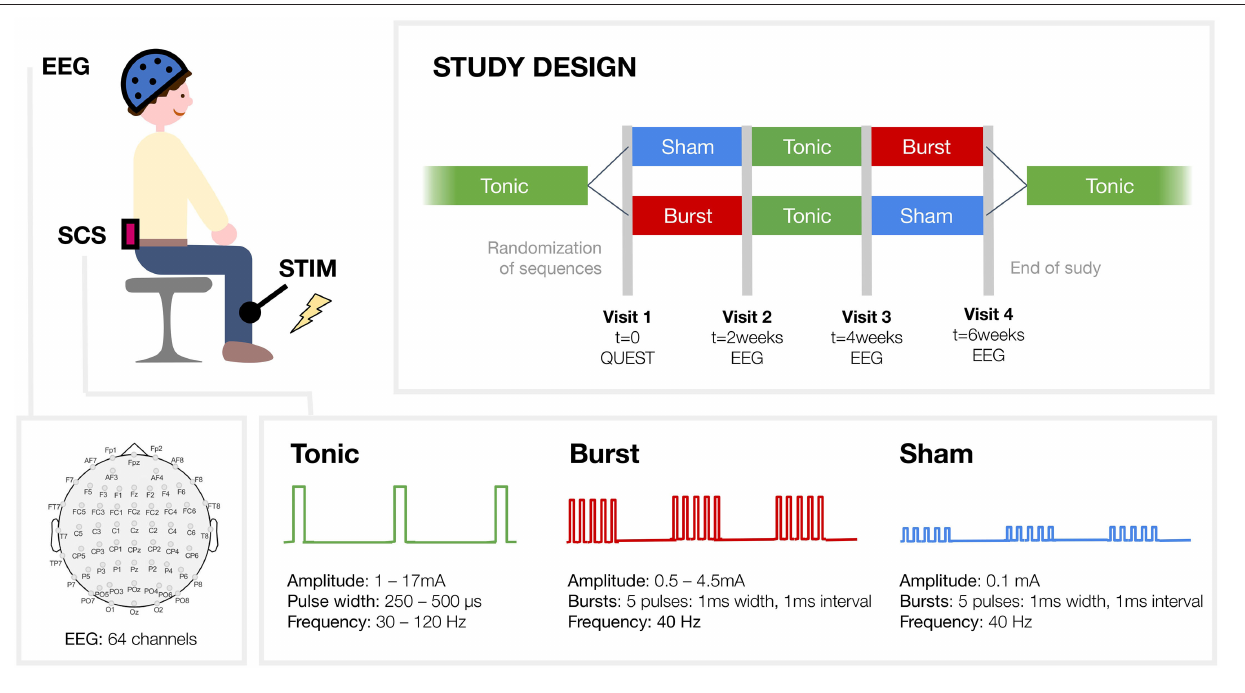
FIGURE 1 | Study design. Patients were evaluating three different spinal cord stimulation (SCS) regimes, each for 2 week: conventional tonic SCS, burst SCS and sham SCS. Participants were randomized to one of the two study arms. Tibial nerve stimulation was applied to elicit somatosensory evoked potentials that were recorded with electro-encephalography (EEG). Two different conditions were studied: the attended condition, where participants had to silently count the administered tibial stimuli, and the unattended condition, where they were asked to mind wander.